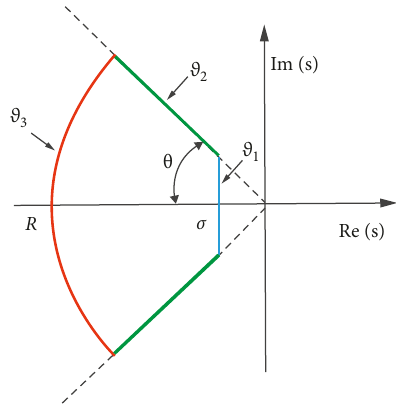
Figure 5: D -region in the s-space.